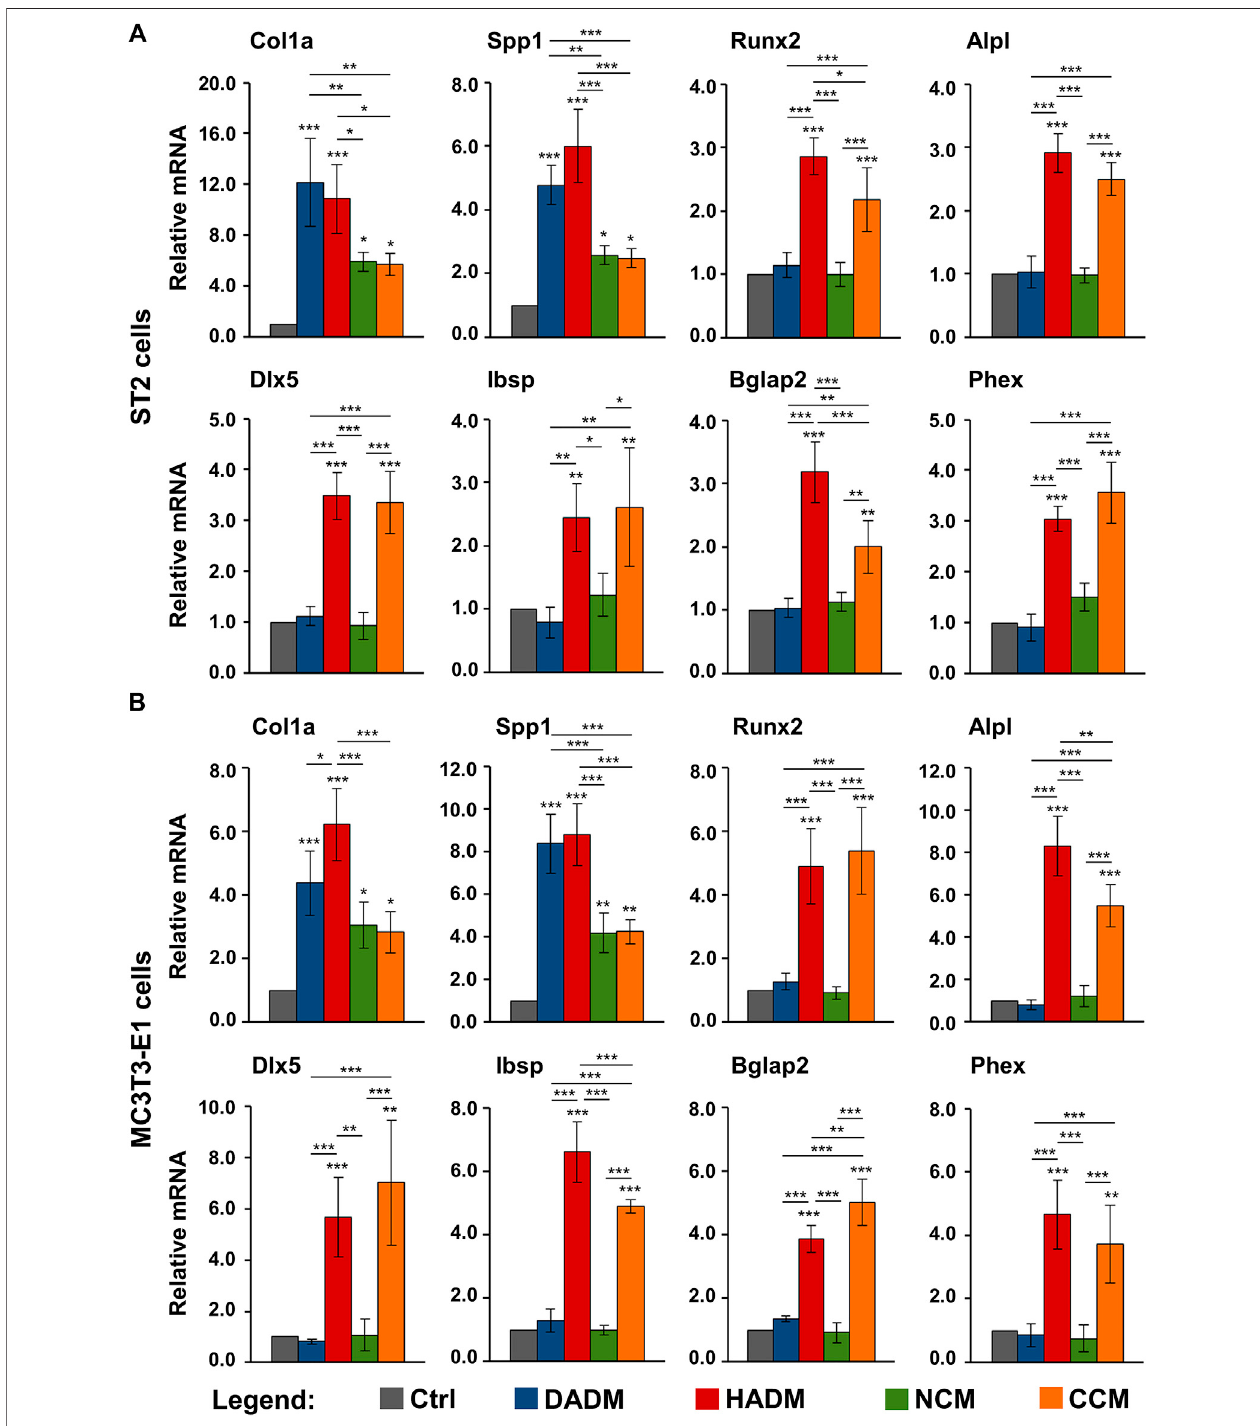
FIGURE 5 | Increased expression of osteogenic differentiation markers in osteoprogenitor cells grown on HADM and CCM collagen-based matrices. ST2 (A) and MC3T3-E1 (B) cells were cultured in the absence of a collagen matrix (Ctrl) or on DADM, HADM, NCM, or CCM collagen-based matrices for 3 days before total cellular RNA was extracted, puri fi ed, and analyzed for the expression of Col1a1, Spp1, Runx2, Alpl, Dlx5, Ibsp, Bglap2, and Phex osteogenic markers by qRT-PCR. Values normalized to Gapdh are expressed relative to the values of control cells. Data represent means ± SD from four independent experiments performed with each of the two cell lines. Signi fi cant differences to the respective controls unless otherwise indicated, *** p < 0.001, ** p < 0.01, * p < 0.05.